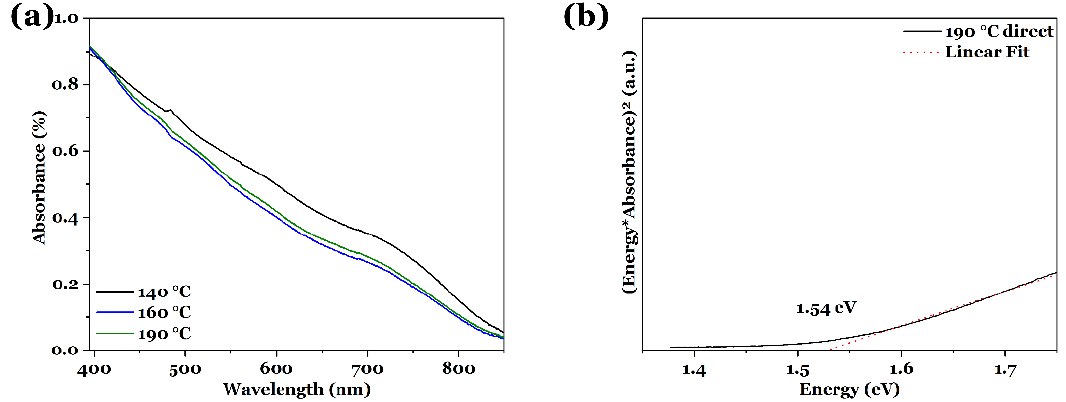
Figure 7. ( a ) UV-vis spectra of CuInS 2 thin films on FTO substrate, synthesized solvothermally with L -cysteine at different reaction temperatures for 18 h. ( b ) Exemplary Tauc plot for direct semiconductors for film_190 °C, indicating a band gap of 1.54 eV.